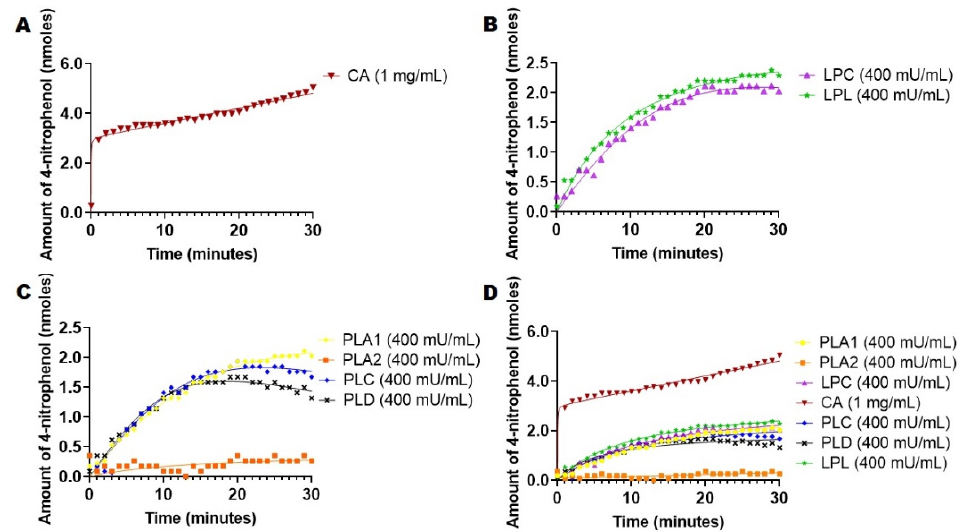
Figure 1. Hydrolysis of 4-nitrophenol acetate catalyzed by different esterases present in the circulatory system at 400 mU/mL (except CA (1 mg/mL)). Enzymatic kinetics were recorded via absorbance at 400 nm. The uncatalyzed hydrolysis of 4-nitrophenyl acetate was deducted from the rate of catalyzed reaction in each case. The amount of 4-nitrophenol released was determined using a calibration curve. ( A) . Hydrolysis with CA. ( B ). Hydrolysis with lipases (LPC and LPL). ( C ). Hydrolysis with Phospholipases (A1, A2, C and D). ( D ). Hydrolysis with all esterases and lipases combined.